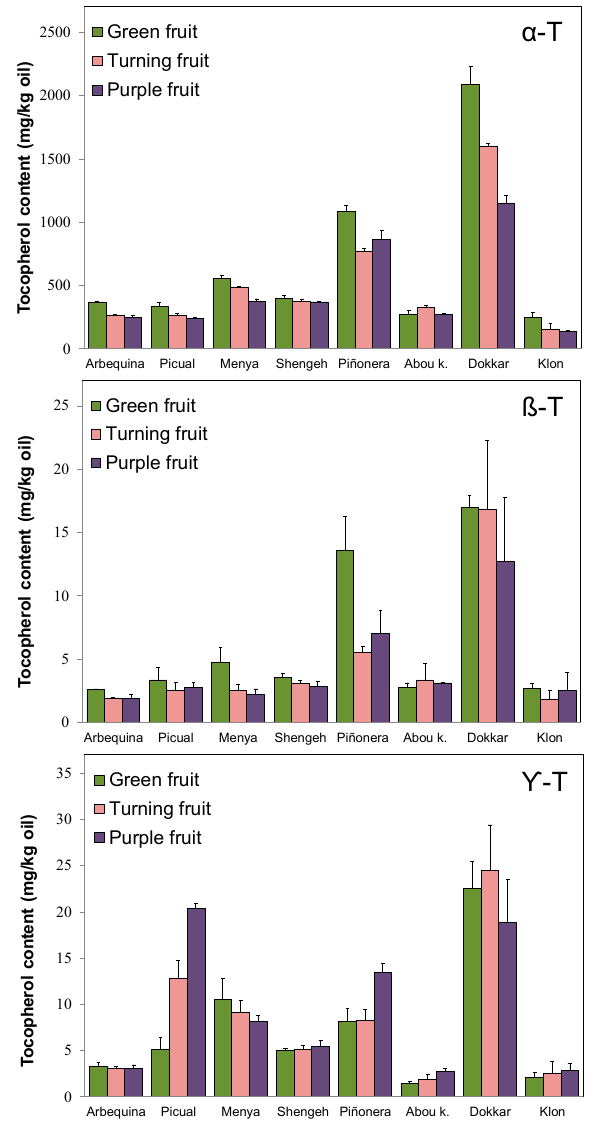
Figure 6. Changes in the contents (mg / kg oil) of the three forms of tocopherol in the oils from selected cultivars from the World Olive Germplasm Collection along the olive fruit ripening (average contents and standard deviations from at least three different crop years): α -T, α -tocopherol; β -T, β -tocopherol; γ -T, γ -tocopherol.